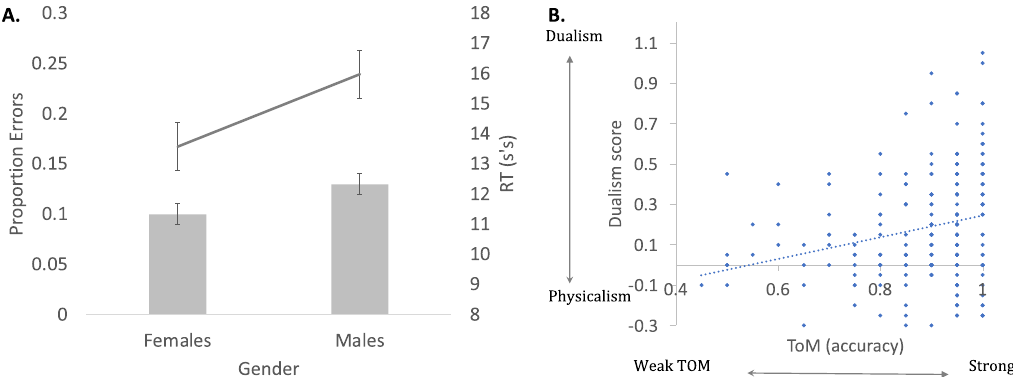
Figure 5. ToM response (the bar graph captures errors; response times are indicated by the line graph) ( A ); and the correlation between ToM accuracy and Dualism scores ( B